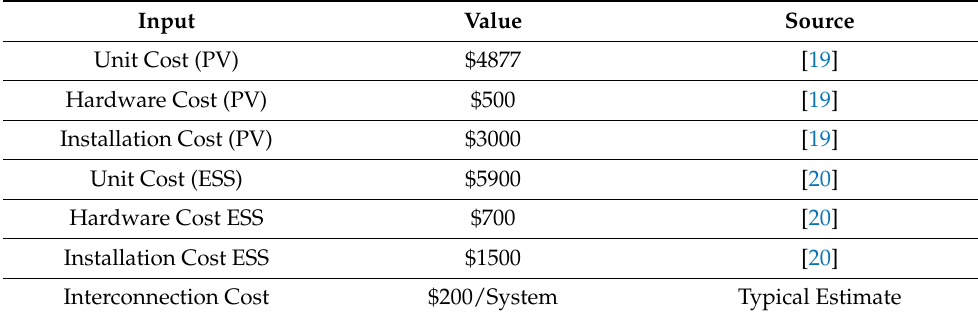
Table 2. PV and ESS cost